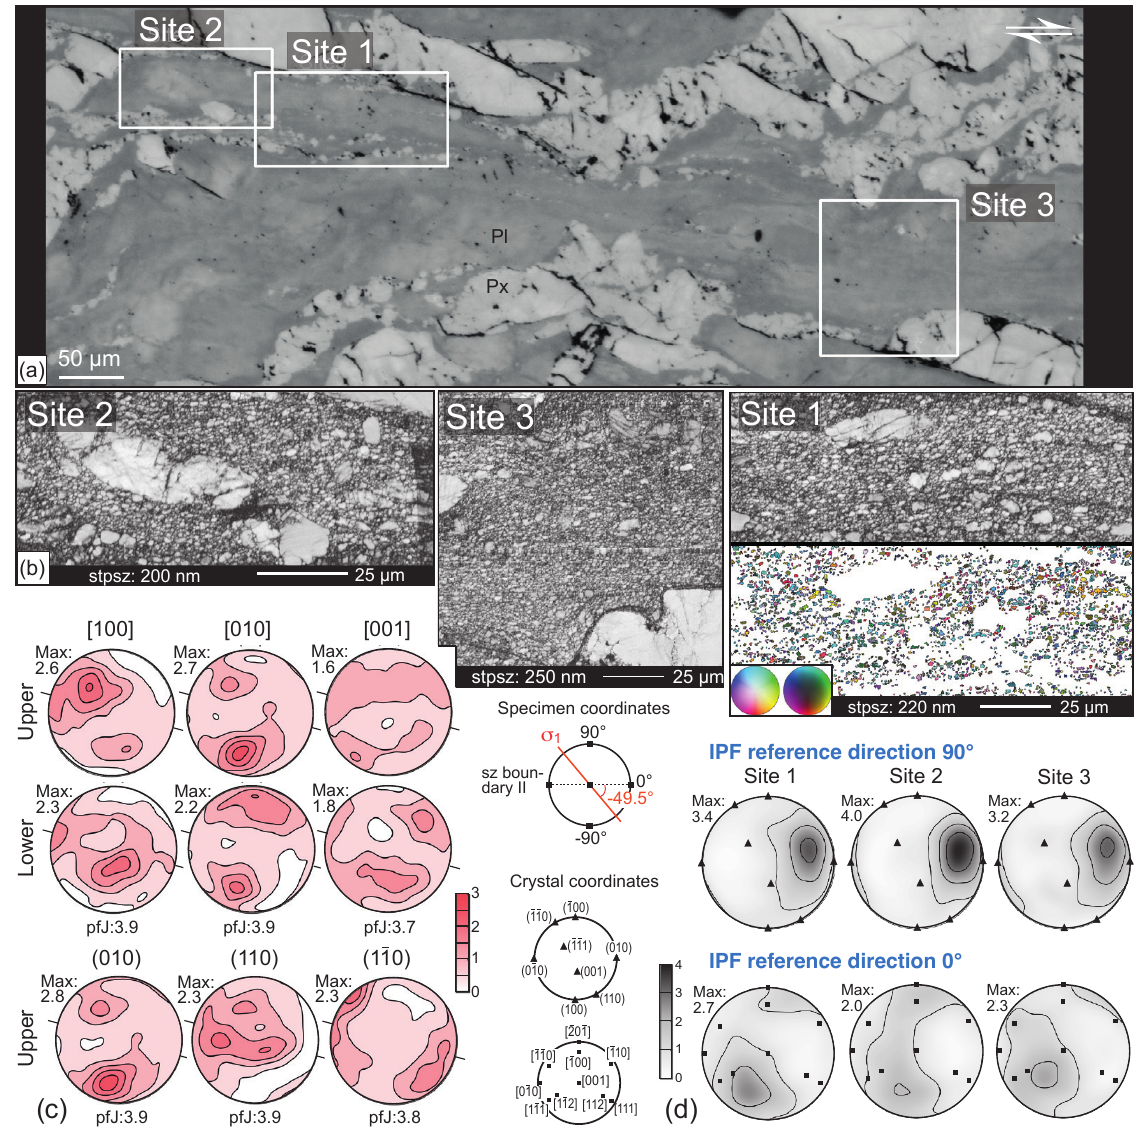
Figure 12. EBSD analysis of Ab+En sample. (a) Reflected light image. EBSD map locations are indicated; Pl: plagioclase, Px: pyroxene. (b) Band contrast images and EBSD map (for site 1, inverse pole figure coloring, x direction); stpsz: step size. (c) Pole figures (equal area projections) plotted from combined data of all sites. Orientation data of grains < 2µm in diameter (and min. > 3 pixels) are plotted. Small black lines at pole figure rims indicate approximate trace of shear band (plunging with 15 ◦ to the right). (d) Inverse pole figures (IPFs) for directions and poles to planes, respectively, for reference directions 90 and 0 ◦ (normal to the global shear plane and parallel to shear direction, respectively). For the specimen coordinate reference sketch, sz: shear zone. Number of grains analyzed: site 1: 2492, site 2: 1647, site 3: